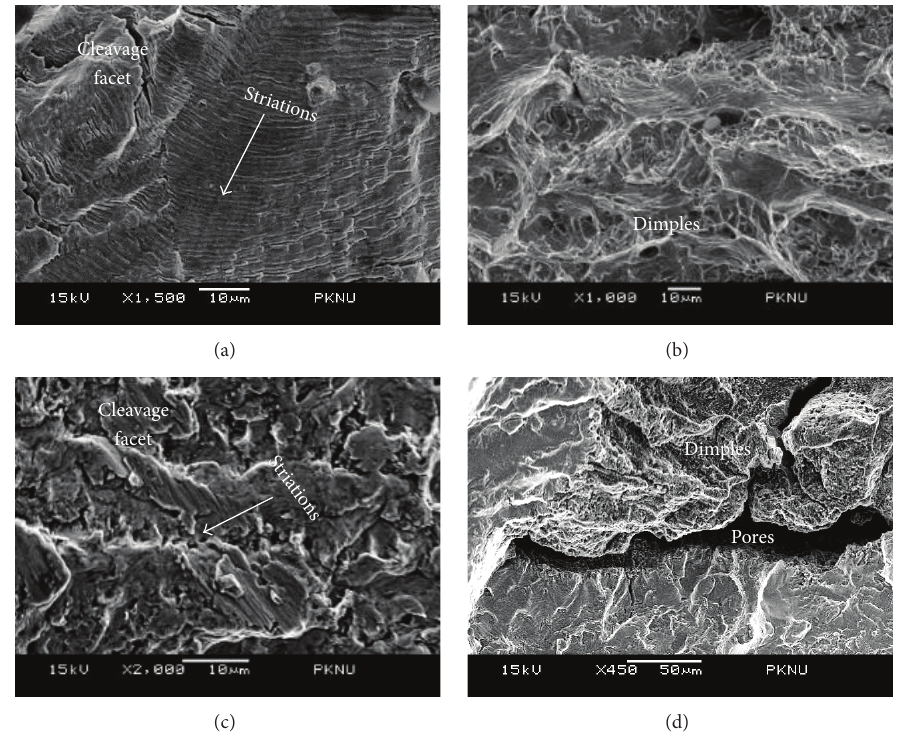
Figure 12: SEM images of the fractograph representing a crack propagation for low and high magnifications for ((a), (b)) Alloy 617 BM and ((c), (d)) Alloy 617 WJ, tested at 1.5% total strain range,